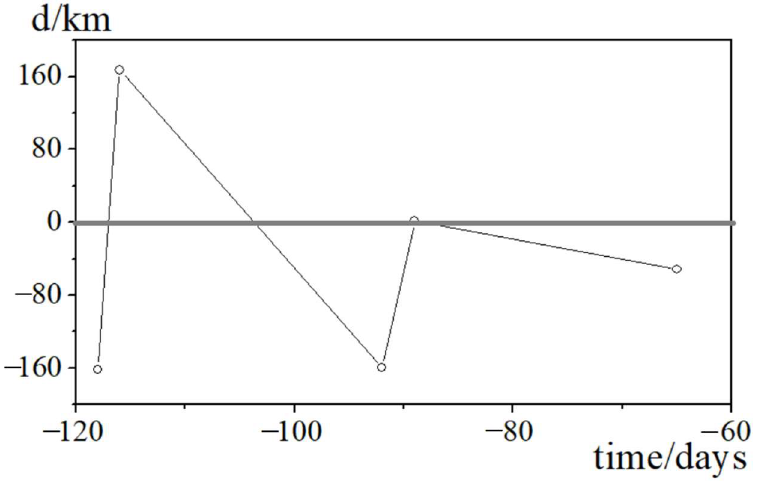
Figure 5. Evolution of distance between geothermal anomaly observation station and epicenter. ”+, −”represent the opposite direction.